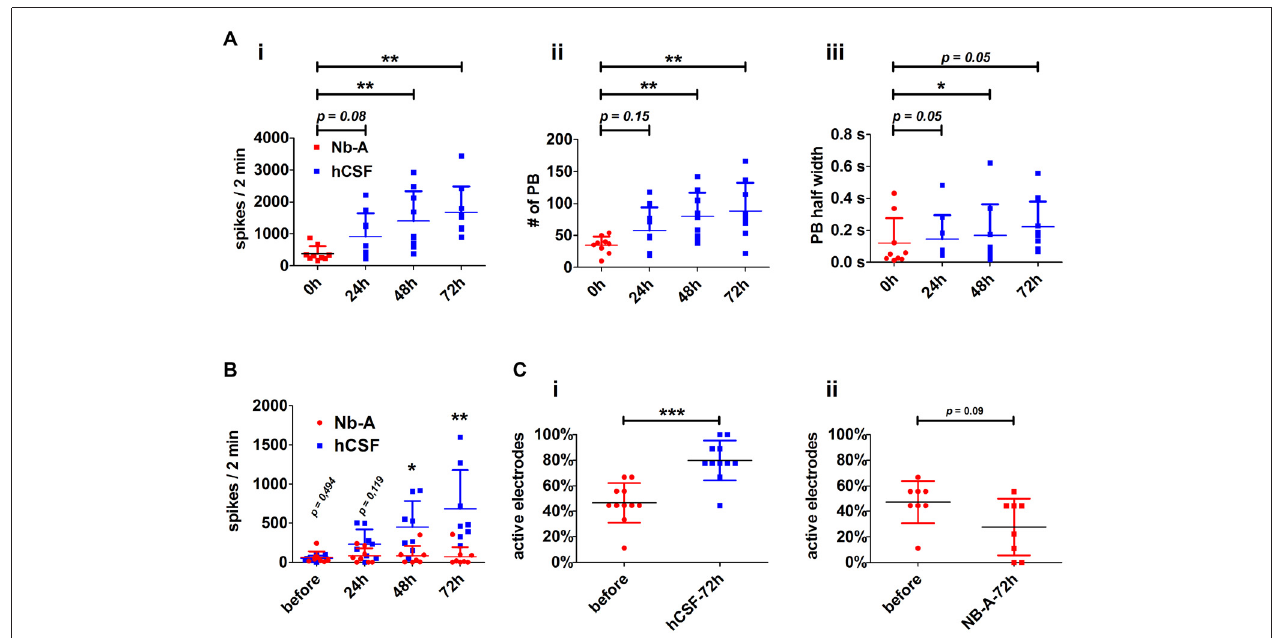
FIGURE 3 | Neuronal paramters describing the functional impact of hCSF on hippocampal neuronal network activity. (A) Diagrams illustrate the course of neuronal network activity after the application of hCSF to high-active hippocampal neurons indicated by the mean number of spikes (i) , number of population bursts (PBs) (ii) and PB half width (PB half width) (iii) . Each dot represents the impact of one individual CSF sample on individual hippocampal neurons (mean ± SD, 5 hCSF-samples tested in six individual neuronal cultures obtained from three independent rat preparations). (B) Diagrams illustrate the mean number of spikes of low-active hippocampal neurons treated either with hCSF (blue) or fresh Nb-A-based media (red) for 3 days. Each dot represents the impact of one individual hCSF-sample on individual hippocampal neurons cultivated in one well of a six-well MEA (mean ± SD, 4 hCSF-samples tested in eight individual neuronal cultures obtained from two independent rat preparations). (C) Diagrams illustrate the percentage of activity detecting electrodes in hippocampal neuronal networks before and 72 h after treatment with hCSF (blue) or fresh Nb-A-based media (red) (mean ± SD, 6 hCSF-samples tested in 11 individual neuronal cultures obtained from three independent rat preparations). ∗ p < 0.05; ∗∗ p < 0.01; ∗∗∗ p <